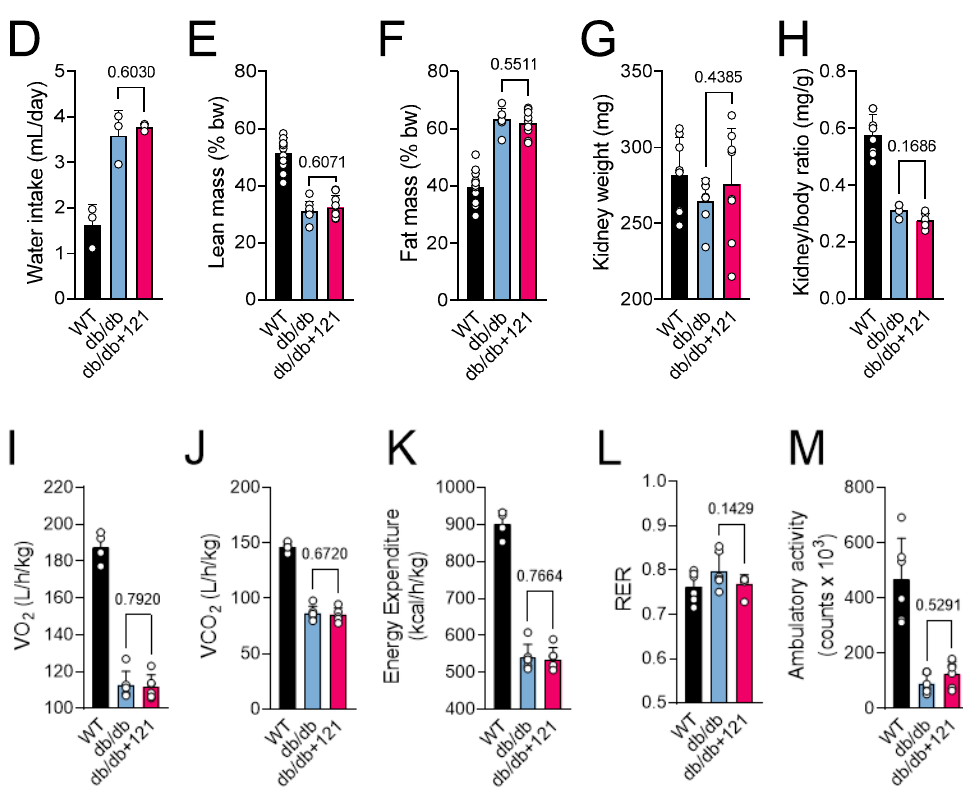
Figure 1. Experimental timeline and nutritional parameters, body mass, locomotor activity, and metabolic activity of db/db mice fed a control diet or a diet containing the AD drug candidate CMS121 for 6 months. Beginning at the 5th week after birth, mice were either kept on the control diet (db/db) or on a diet containing CMS121 (db/db + 121) ad libitum (See M&M for details). ( A ) Timeline and end points analyzed. Wildtype (WT) mouse data are presented as a reference. Cumulative food intake ( B ) and body weight ( C ). Food intake per animal was based on the food consumption in cages containing 3 mice. Data ( B , C ) are presented as average ± SEM (n = 8–12). Differences between linear regression slopes of control and CMS121-treated db/db mice were analyzed, and the p -values are indicated. During the 13th and 15th weeks, respectively, treatment, water intake (n = 3), and body mass (n = 8–9) indexes were obtained: ( D ) water intake; ( E ) lean mass, and ( F ) fat mass. Kidney weight ( G ), and kidney/body weight ratio ( H ) data were obtained from 7–8 animals per group at the end of the experiment. Metabolic activity (( I – M ), n = 6) was evaluated at the 15th week of treatment. ( I ) Oxygen consumption (VO 2 ); ( J ) carbon dioxide production (VCO 2 ); ( K ) energy expenditure; ( L ) respiratory exchange rate (RER); and ( M ) overall ambulatory activity. Data ( D – M ) are presented as mean ± SD, and p -values are indicated for the untreated control db/db mice as compared to the CMS121-treated mice. Values of the WT group are presented as a reference. One-way ANOVA was used to detect mean changes, and differences between db/db and db/db + 121 were evaluated by the Holm–Sidak post-hoc